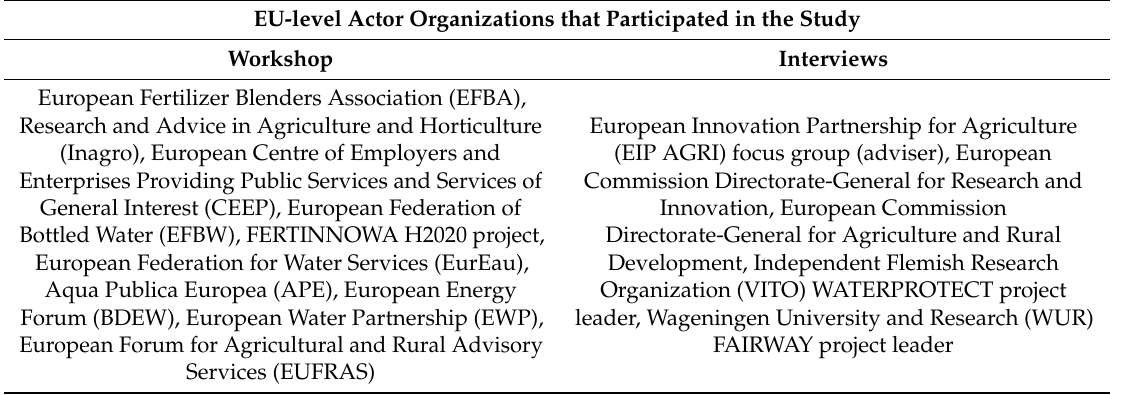
Table 1. Representative EU-level actor organizations attending the workshop and